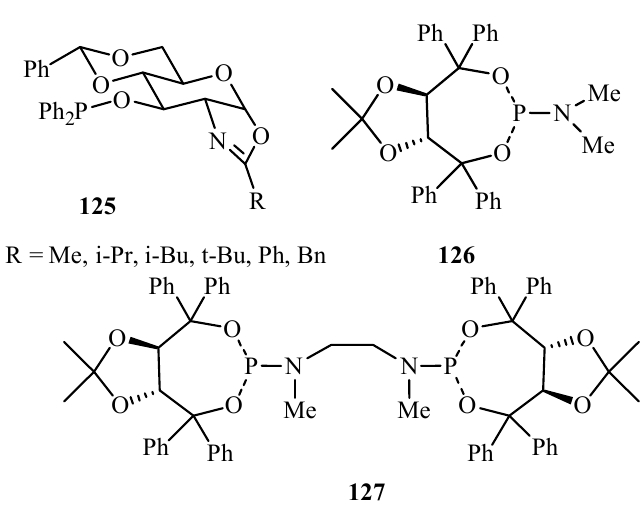
Figure 15. Carbohydrate based ligands reviewed by Diéguez [51].